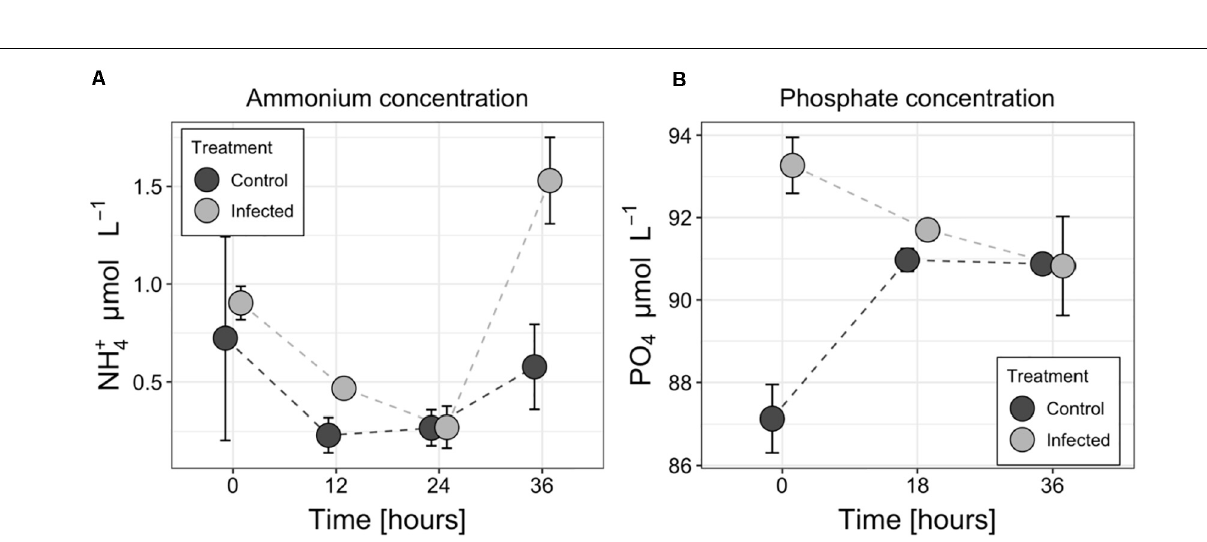
Frontiers in Microbiology |